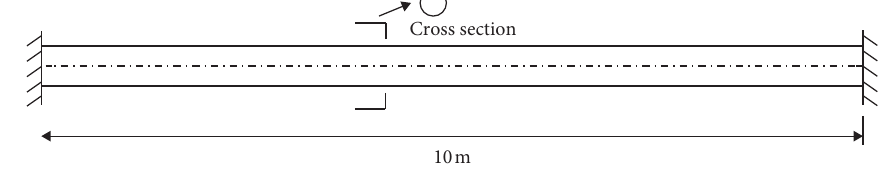
Figure 3: Schematic diagram of the beam structure.